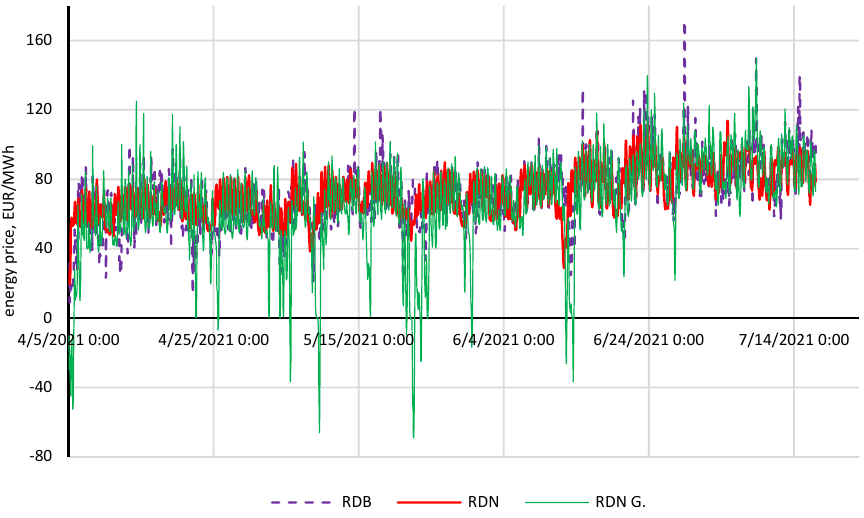
RDN G. Figure 4. DAM (day-ahead market) and IDM (intraday market) prices on POLPX 2021 Warsaw and DAM prices Germany, in the period 5 April 2021–16 July 2021 [31,35]. Energy prices in Poland in the analysed period were practically never lower than 40 EUR/MWh (with minor exceptions), while in Germany prices were negative on several occasions. Detailed ordered price values are presented in Figure 5.